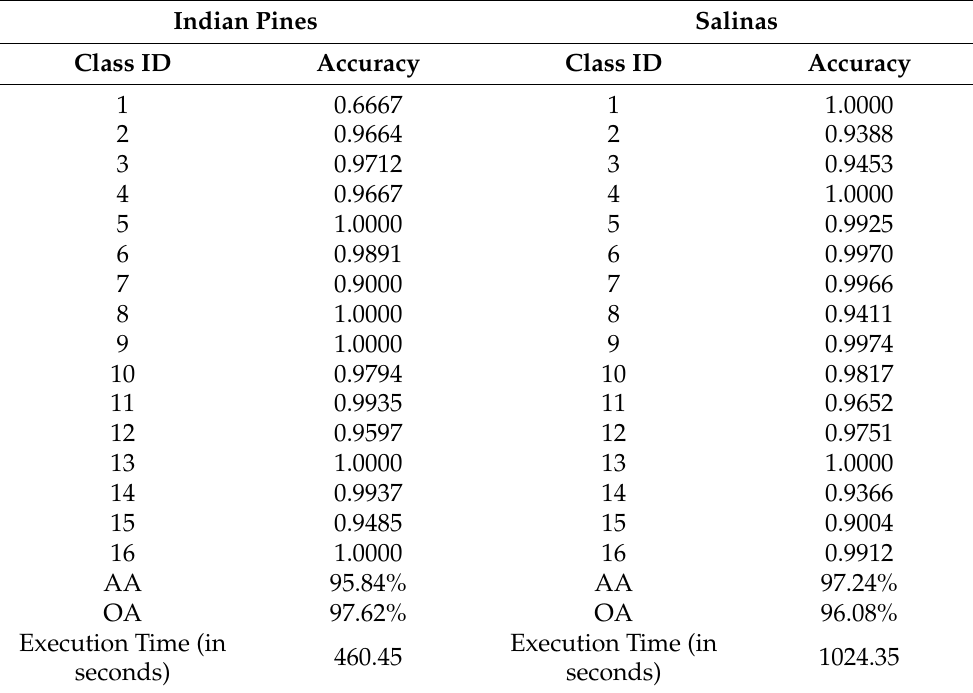
Table 6. Details of class-wise accuracy of Indian Pines and Salinas